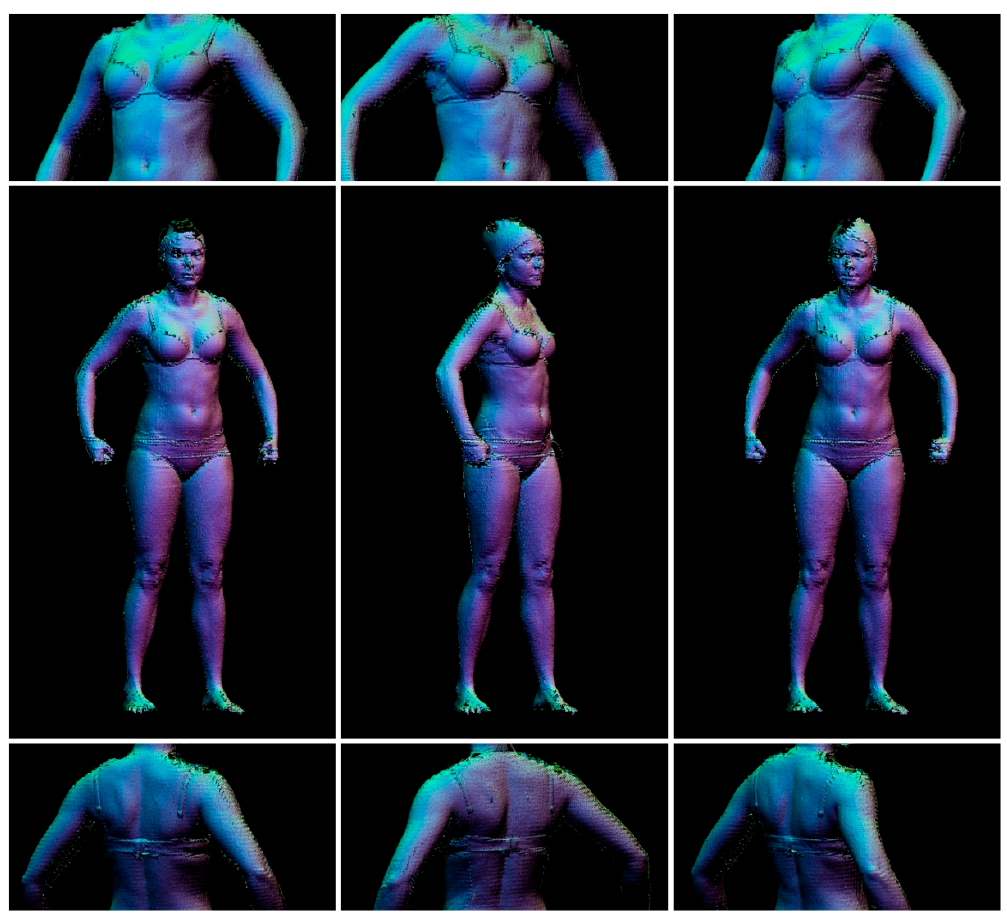
Figure 15. Three frames depicting a subject while turning her hips. Middle row : full images; top and bottom rows : zoomed-in portions of the images in the middle row .